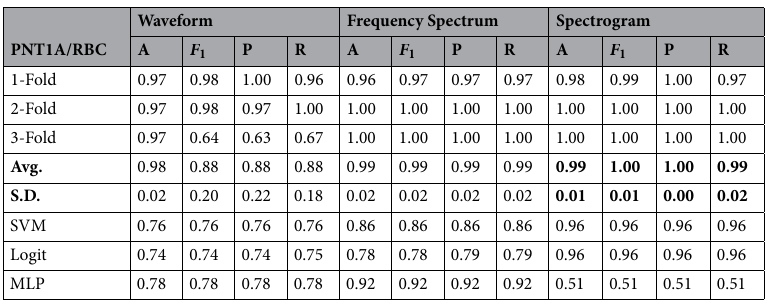
Table 1. Performance of the proposed model in waveform, frequency spectrum, and spectrogram. A, F 1 , P, and R indicate accuracy, F 1 score, precision, and recall, respectively. Avg. and S.D. refer to the mean and standard deviation of three folds, respectively. Models with the highest evaluation metrics are highlighted in [bold].